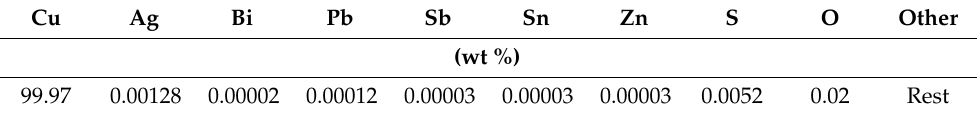
Table 1. Chemical composition of the input material (ETP grade copper (electrolytic tough pitch)). Cu Ag Bi